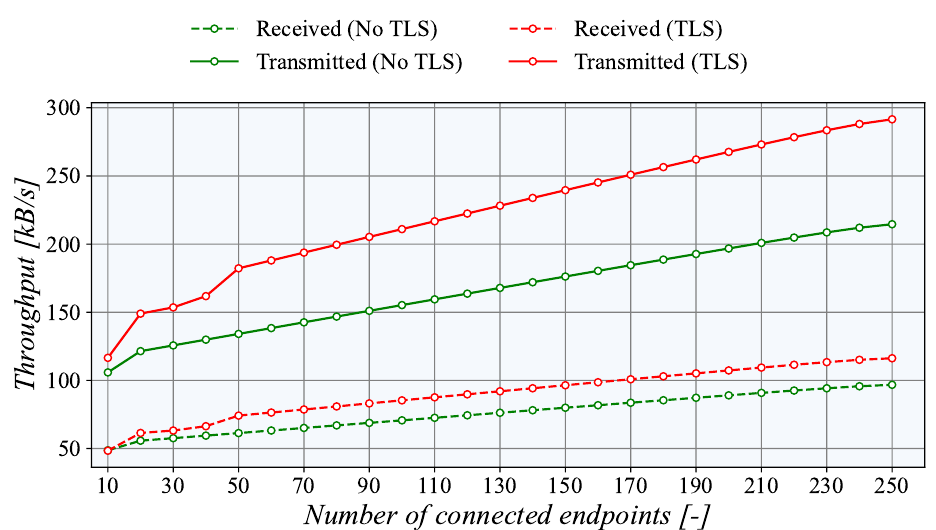
Figure 15. TASE.2 network interface utilization during PUSH